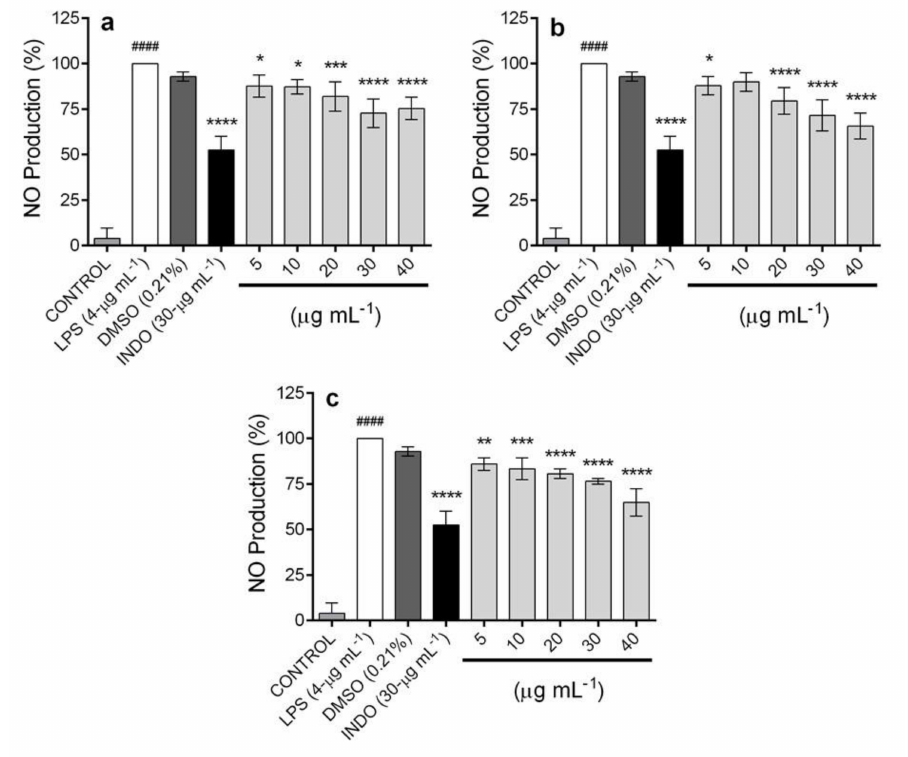
Figure 8. E ff ect of ethyl acetate extracts from A. pinchichensis cell suspension cultures on the nitric oxide (NO) production in lipopolysaccharide (LPS)-stimulated RAW 264.7 macrophages. ( a ) extract from day 8 (D8); ( b ) extract from day 12 (D12); ( c ) extract from day 16 (D16). The values are expressed as the mean ± SD of three independent experiments ( n = 3). Significance was determined using ANOVA followed by Dunnett’s multiple comparisons test (#### p < 0.0001 LPS compared with the control group; * p < 0.05 and *** p < 0.0001 DMSO, INDO (indomethacin), and extracts compared with the LPS